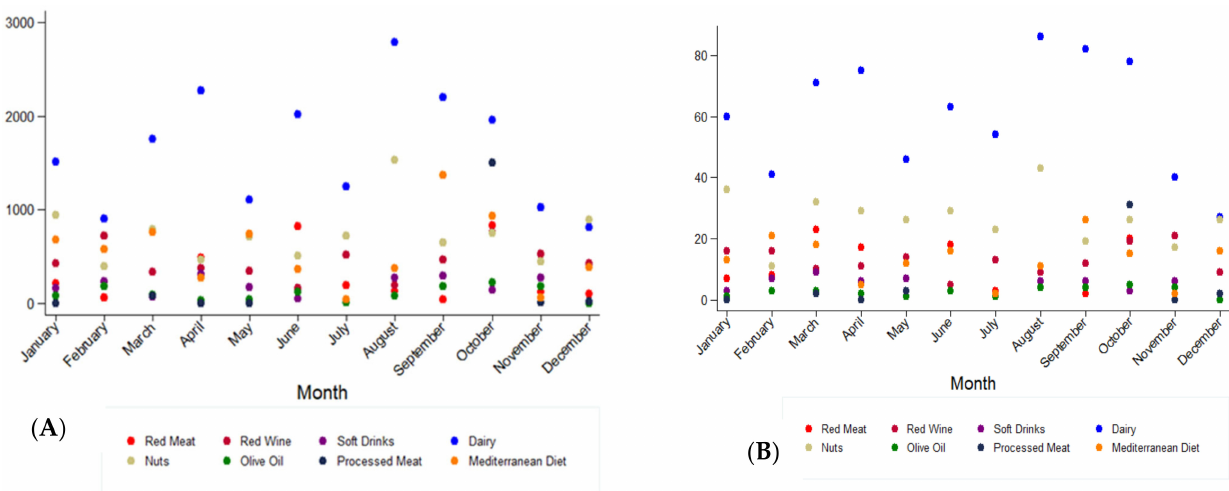
Figure 5. Monthly distribution of tweets ( A ) posted by 25 US media outlets and retweets ( B ) generated by Twitter users between 2009 and 2019. The scatter plot represents all the tweets ( A ) posted by the 25 major US media outlets selected in the study and the retweets ( B ) generated by their followers. Each food group is represented by a colored dot according to the following categories: red meat, red wine, soft drinks, dairy, nuts, olive oil, processed meat, and Mediterranean diet. Comparisons between months were not significant (figure ( A ): p -value = 0.91, figure ( B ): p -value = 0.73). p -value by Kruskall–Wallis H